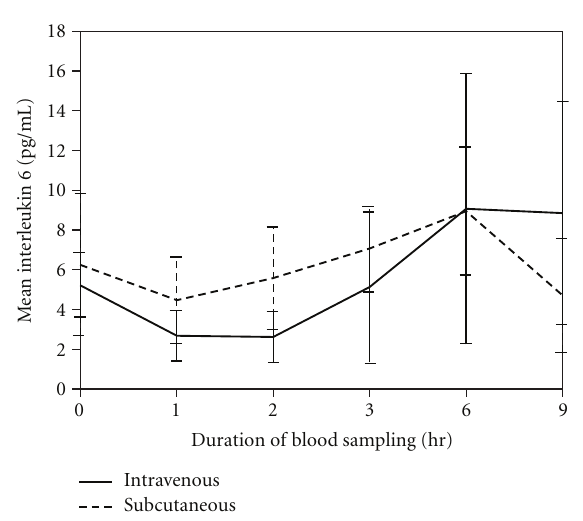
Figure 4: Mean serum IL-6 concentrations for the IV and SC groups at di ff erent sampling times after tramadol administration ( P = 0 .